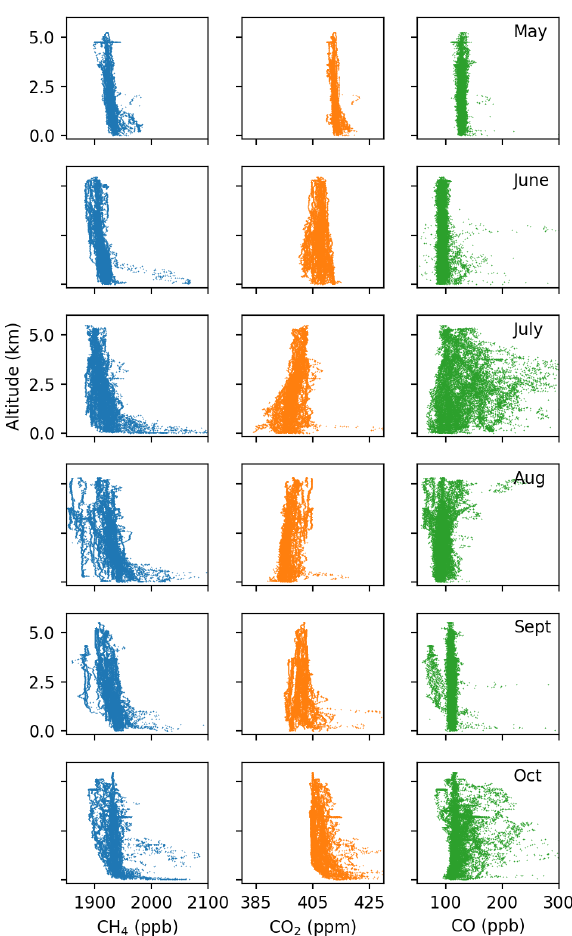
Figure 4. Composite plots of the CH 4 (left column), CO 2 (center column), and CO (right column) measurements acquired during the Arctic-CAP airborne campaign in 2017. Broad seasonal cycle and near-surface enhancement (depletions) can be seen as well as the impact of fires on the free-tropospheric CO.